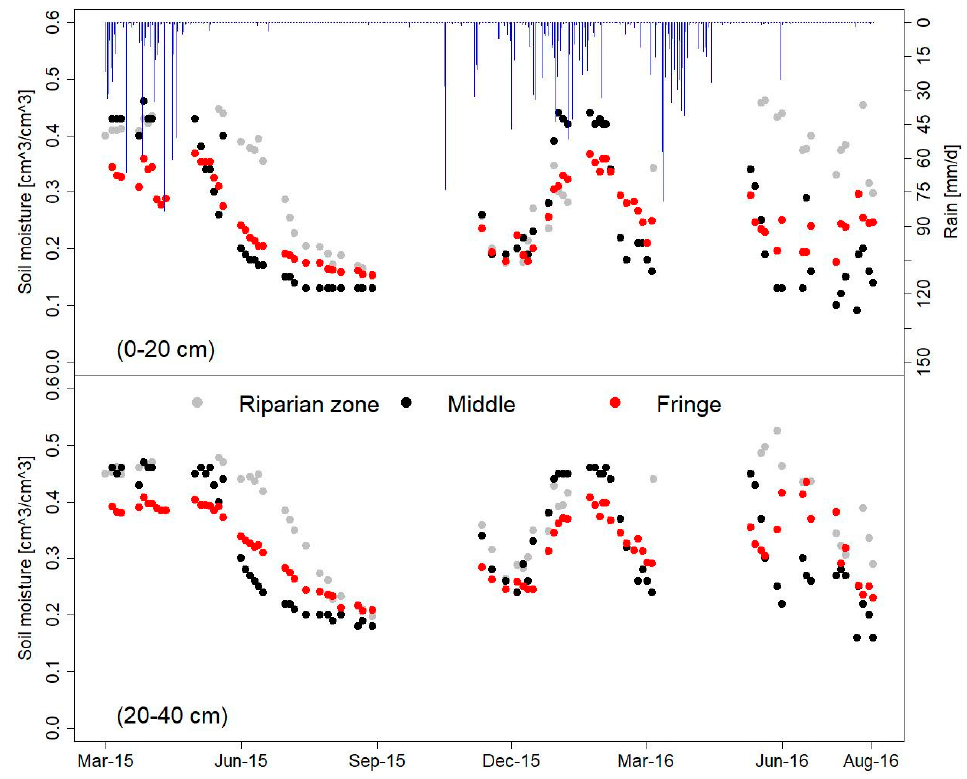
Figure 5. Temporal variation in soil moisture content along hydrological zones of the floodplain transect.